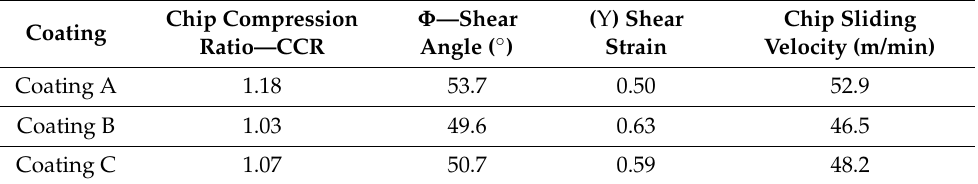
Table 3. Tribological performance evaluated through chip characteristics for the TiB 2 coatings.